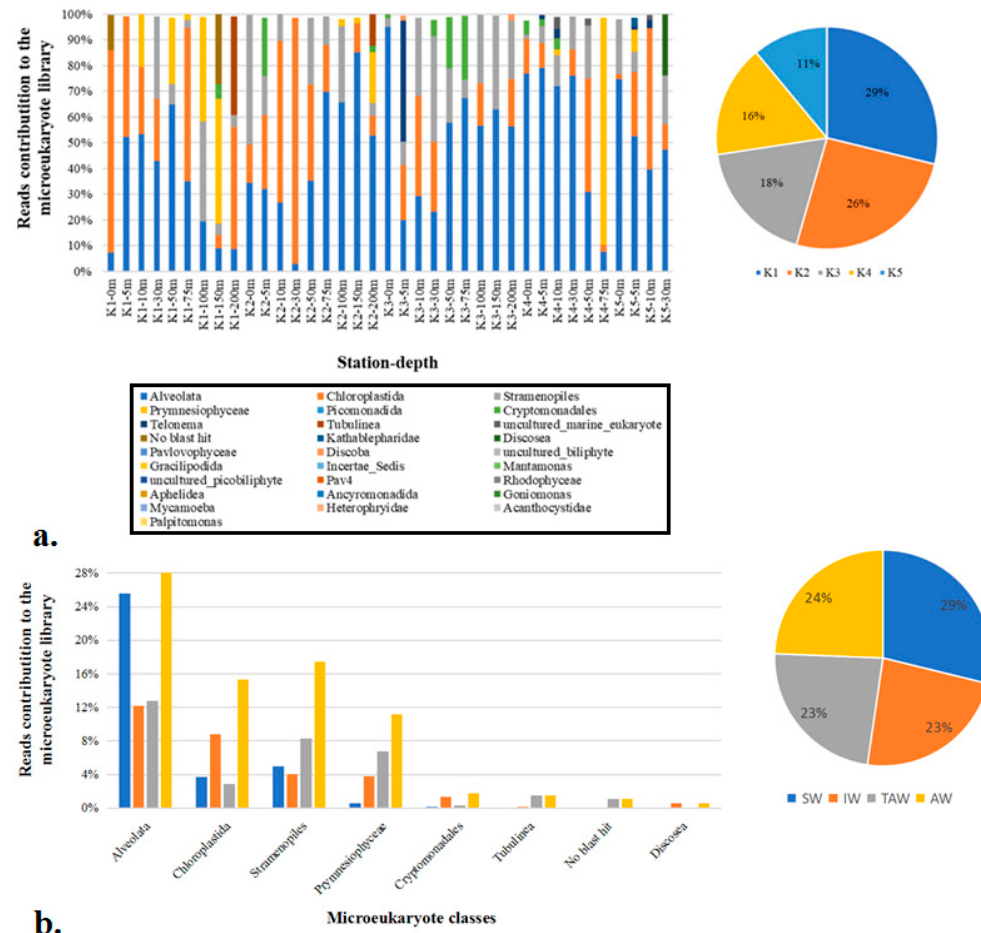
Figure 9. Proportions of small eukaryotes contributing no less than 1% to the small eukaryotic DNA liabrary in Kongsfjorden in 2018 at different depths of stations ( a ) and at different watermasses ( b ). SW = surface water; IW = intermediate mixed water; TAW = Transformed Atlantic Water.